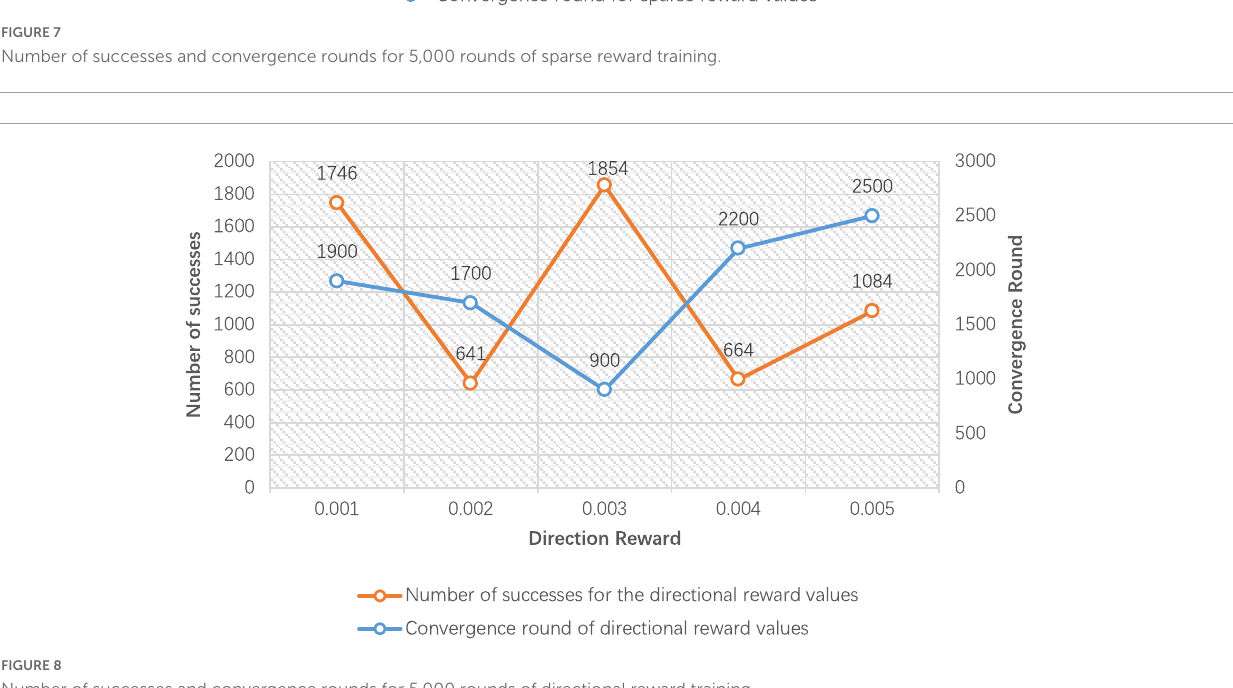
FIGURE8 Number of successes and convergence rounds for 5,000 rounds of directional reward training.